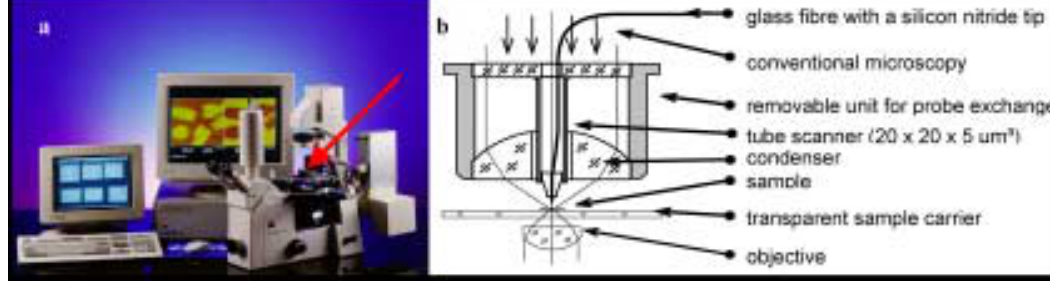
Fig. 1. (a) Setup of SNOM 210 based on an inverted far-field microscope. The arrow points at the condenser holding, the SNOM scan unit, and fibre probe schematically described in (b). (b) Schematic representation of the condenser and the integrated SNOM scan unit. (First published in Hausmann et al., Microscopy and Analysis 71 (May 2001), 5–7.)